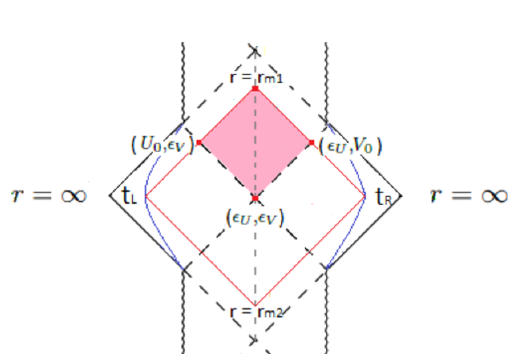
Figure 2 . Joint terms needed for the action of the black hole